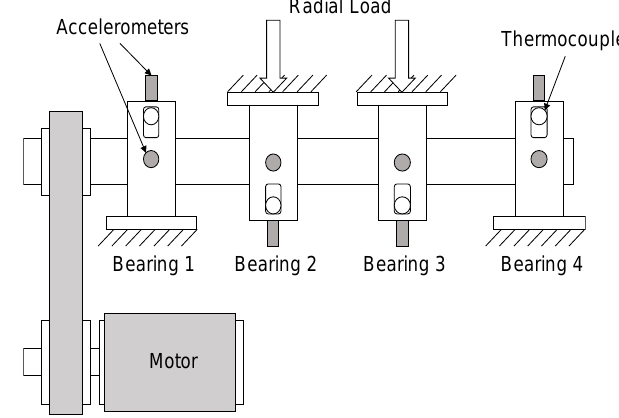
Figure 1. IMS bearing test set up and sensor’s configuration. Table 1. Comparison of signal processing technniques using the NASA IMS bearing